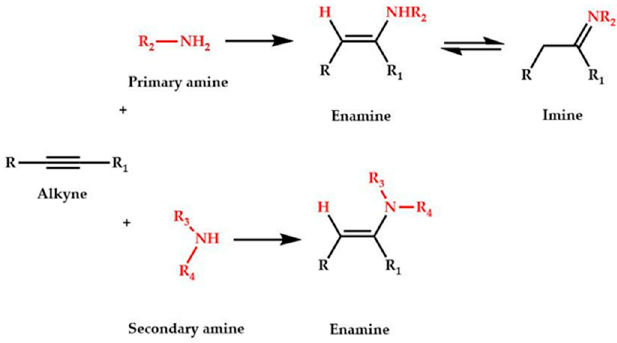
Figure 1. Structure of the most used NHC ligands.